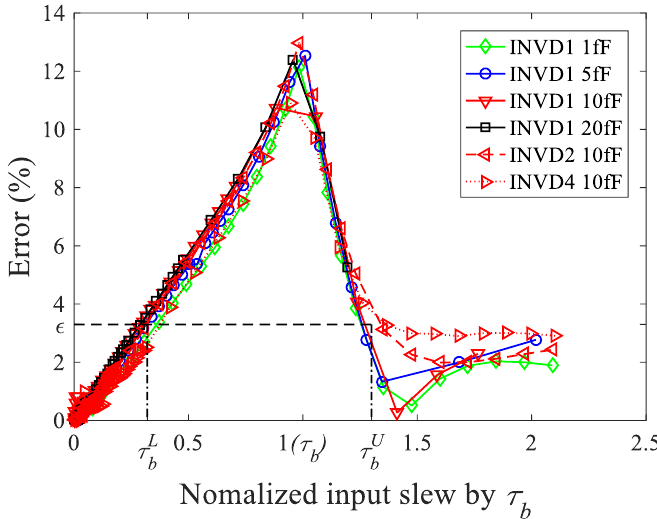
Figure 3. Error of the proposed delay variation model with normalized τ . Based on the tolerable error-adaptive boundary factors, θ L ( ε ) and θ H ( ε ), the delay vari- ation model for transitional region could be analytically derived as the linear